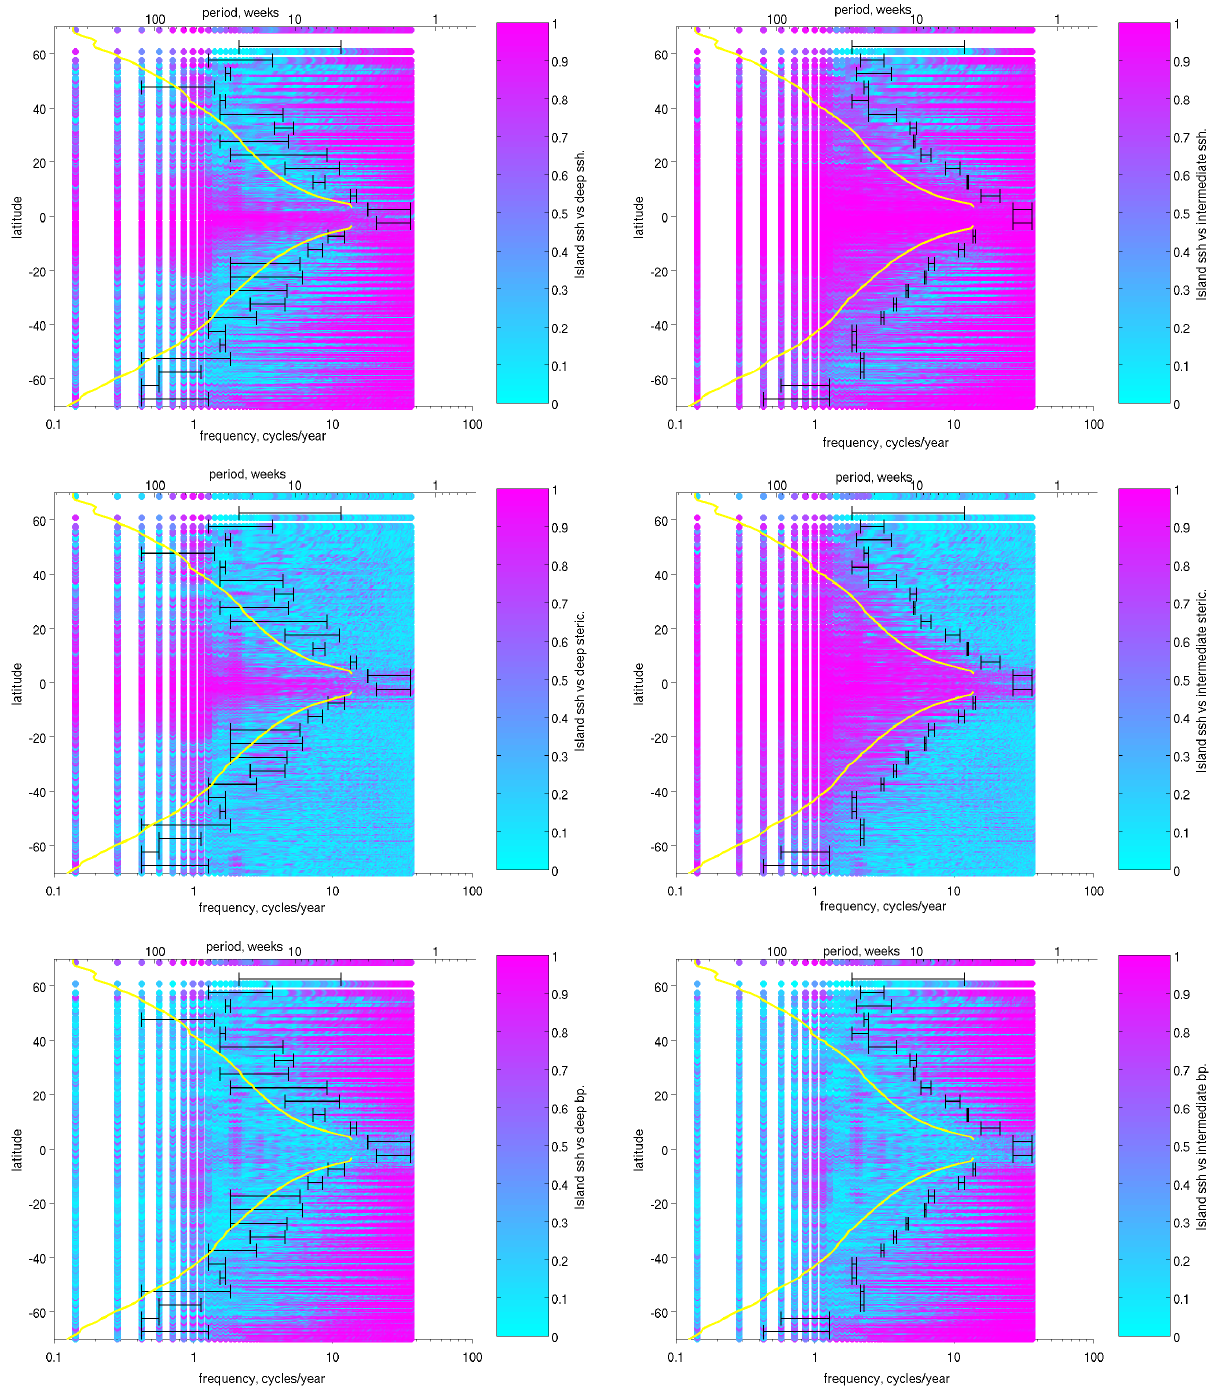
Fig. 7. Magnitude squared coherence of sea-surface height at “control island” and (panels from top to bottom) sea-surface height ( h ), steric height ( φ ), and bottom pressure ( p ), in surrounding ring. Left-hand panels are for distant ring, right-hand panels intermediate rings. Coherence is plotted for every island by latitude and frequency; pink dots indicate a high coherence and blue low. Black bars emphasize the transition region between γ hφ and γ hp . Linear baroclinic Rossby waves are possible only to the left of the yellow